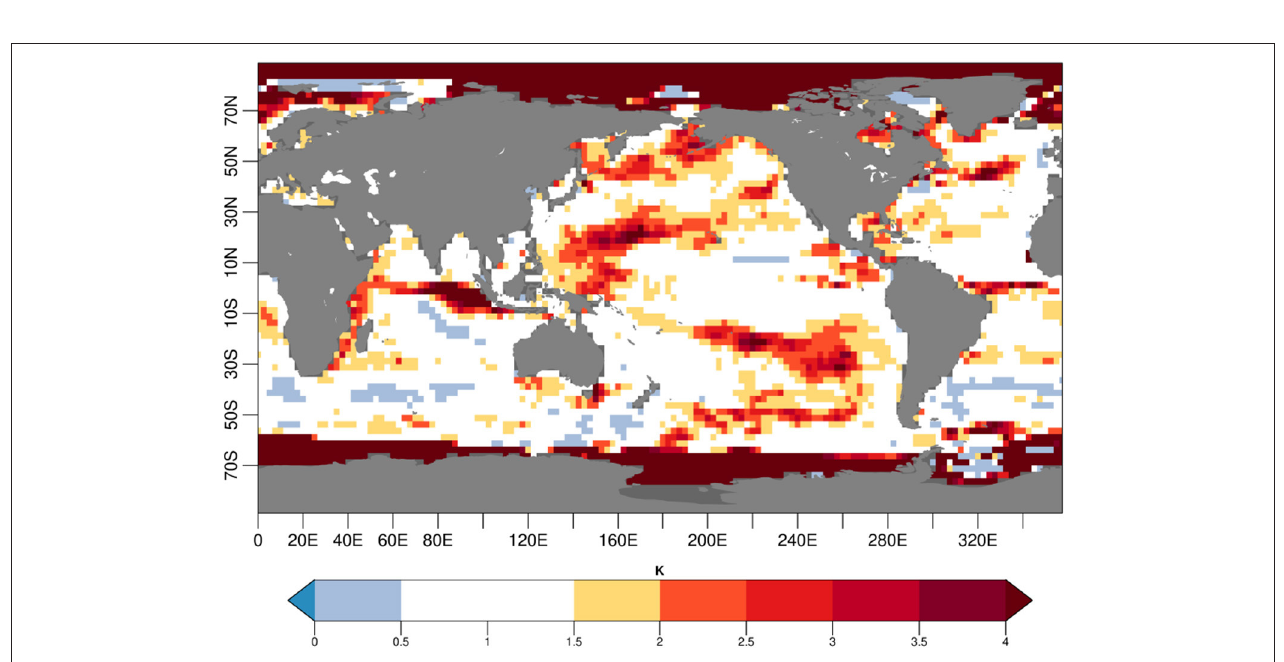
FIGURE 2 | Ratio of SST model variance over the NEMOVAR-ORAS4 variance calculated over the November 1960–2014 start dates. The NEMOVAR-ORAS4 variance is calculated concatenating the 5 ensemble members available, while for the model one EC-Earth3 historical simulation is used.